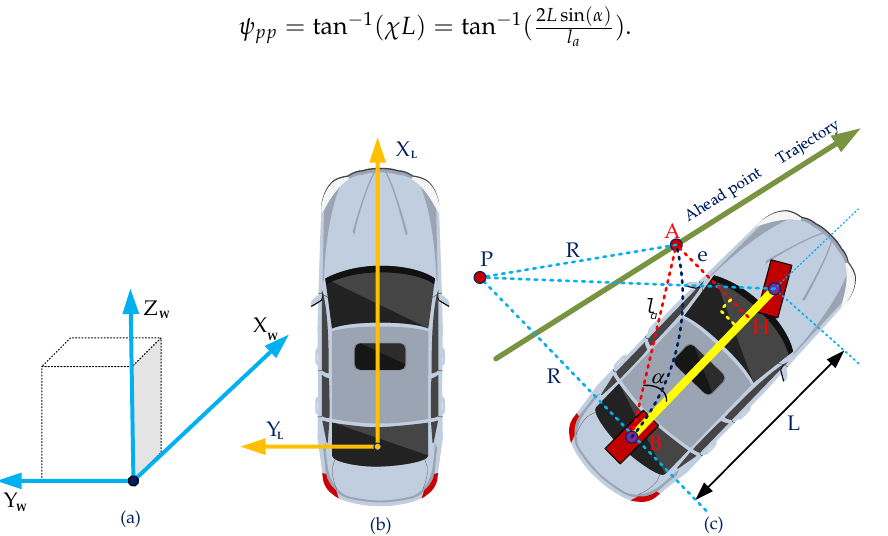
Figure 8. The coordinate systems in our automated driving; ( a ) the global coordinate system in the offset-Universal Transverse Mercator (UTM) frame; ( b ) the local vehicle coordinate system; ( c ) the geometry of path-pure pursuit